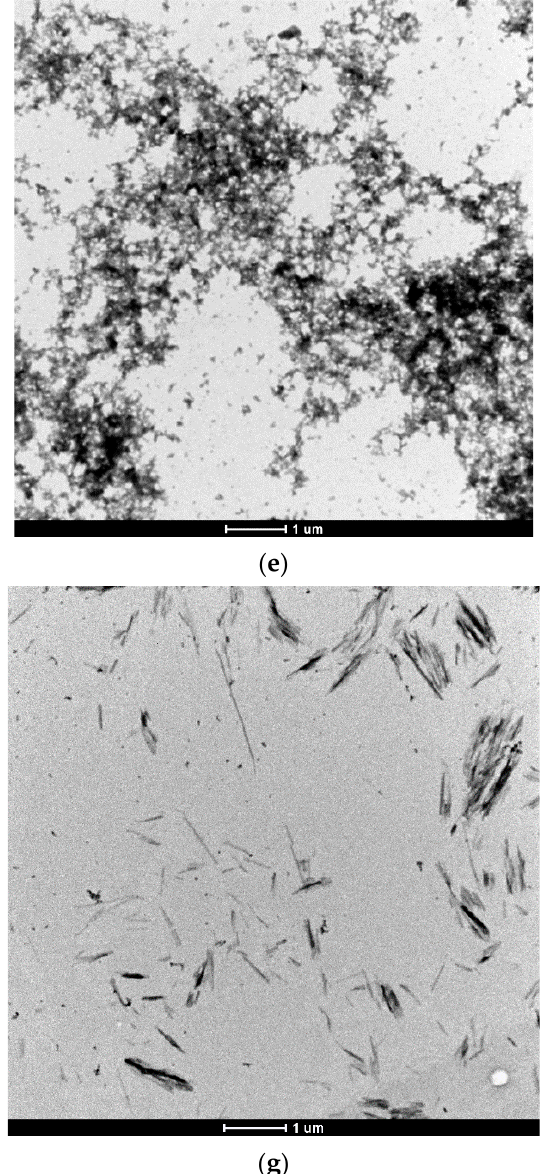
Figure 2. TEM micrographs of the effect of different concentrations of clusterin on SEVI fibril formation. Samples were taken at the end of a two-day incubation with either PAP248–286 or preformed fibrils of SEVI. PAP248–286 was at 2 mg/mL with varying concentrations of clusterin: ( a ) 0, ( b ) 3, ( c ) 20, ( d ) 40, ( e ) 200 μ g/mL; ( f ) Preformed 2 mg/mL SEVI fibrils with 200 μ g/mL of added clusterin; ( g ) Preformed 2 mg/mL SEVI fibrils PAP248–286 incubated for three days without clusterin. The results are representative of three or more individual experiments. The scale bars represent 1 µ